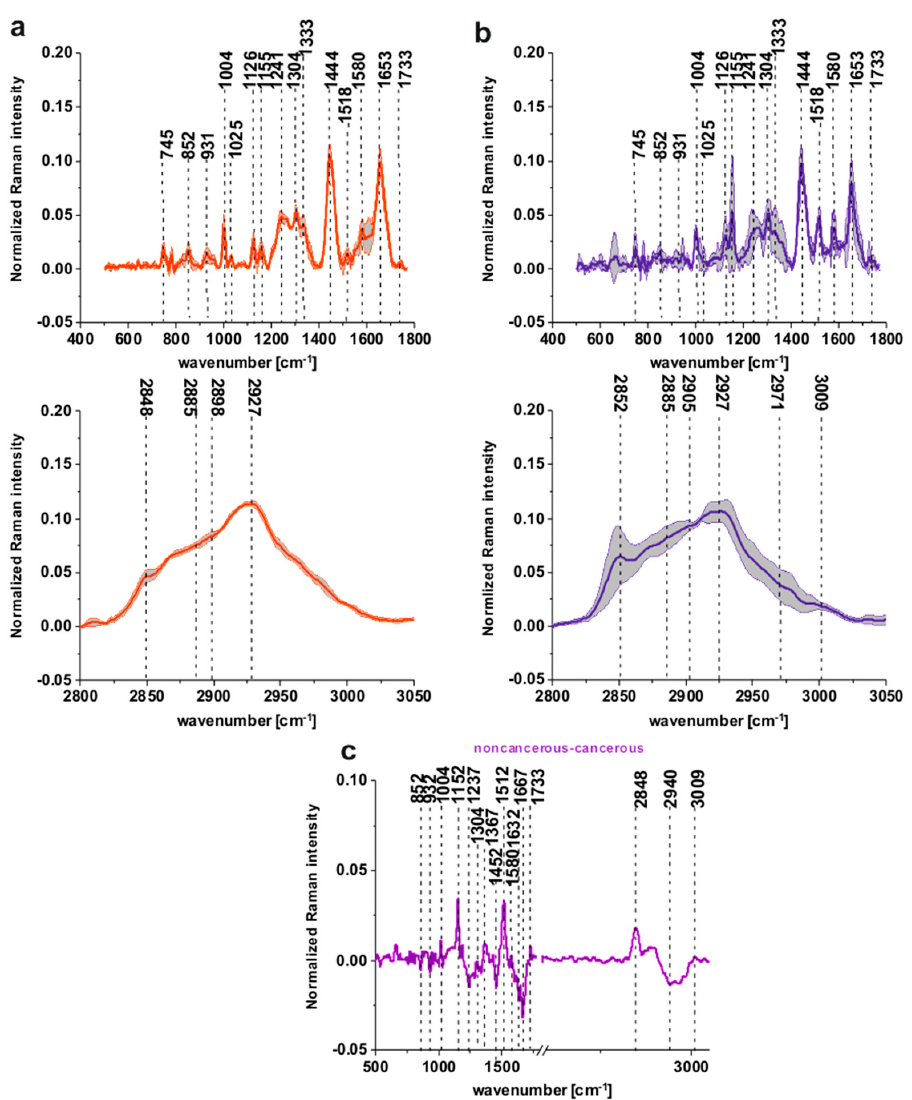
Figure 3. The mean spectra typical for the noncancerous and the cancerous human colon spectra - tubular carcinoma cancer stage G2 based on 36,500 single spectra recorded during Raman measurements of the cancerous ( a ) (red line) and the noncancerous ( b ) (blue line) tissues for patients P1-P5, the differential spectrum between the normalized mean Raman spectra of the noncancerous and the cancerous human colon tissues, tubular carcinoma, cancer stage G2 based on 36,500 Raman single spectra for tubular carcinoma of colon, cancer stage G2 ( c ).